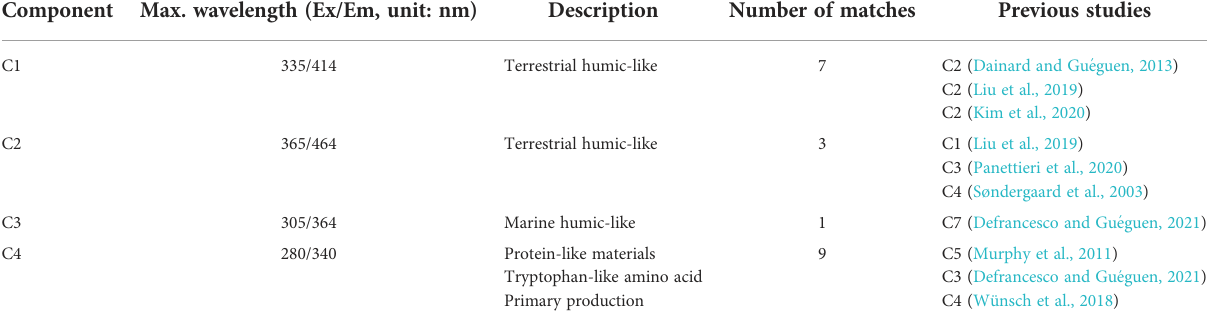
TABLE 2 Optical properties of FDOM components identi fi ed by the PARAFAC model from Hwasun Bay, Jeju Island. Component Max. wavelength (Ex/Em, unit: nm)